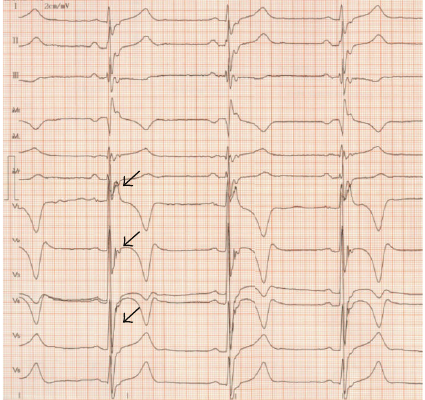
Figure 3: Body surface 12-lead ECG recording in 2cm/mV and 50 mm/S. The arrows indicate epsilon waves, fractionated QRS complexes, and terminal S wave prolongation.